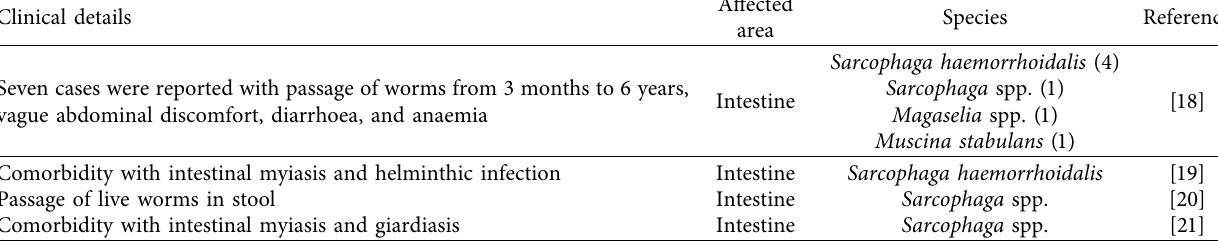
Table 1: Clinical presentation, site of infestation, and the species of fly larvae in reported cases of enteric myiasis. Clinical